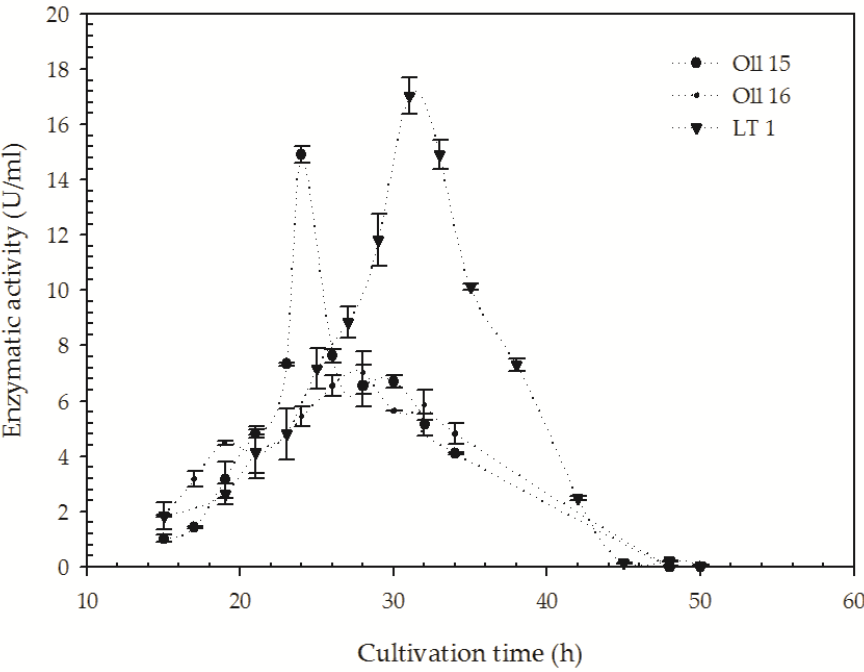
Figure 3. Keratinolytic protease production profiles of the B. citotoxycus strains. Strains were incubated in minimal media supplemented with 10 g·L –1 of whole feather at 50 °C for 50 h and centrifuged at 120 rpm.